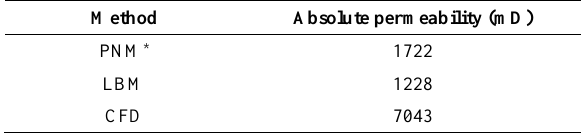
Table 2. The estimated absolute permeability of water, in the x-direction, in the S1-subsection